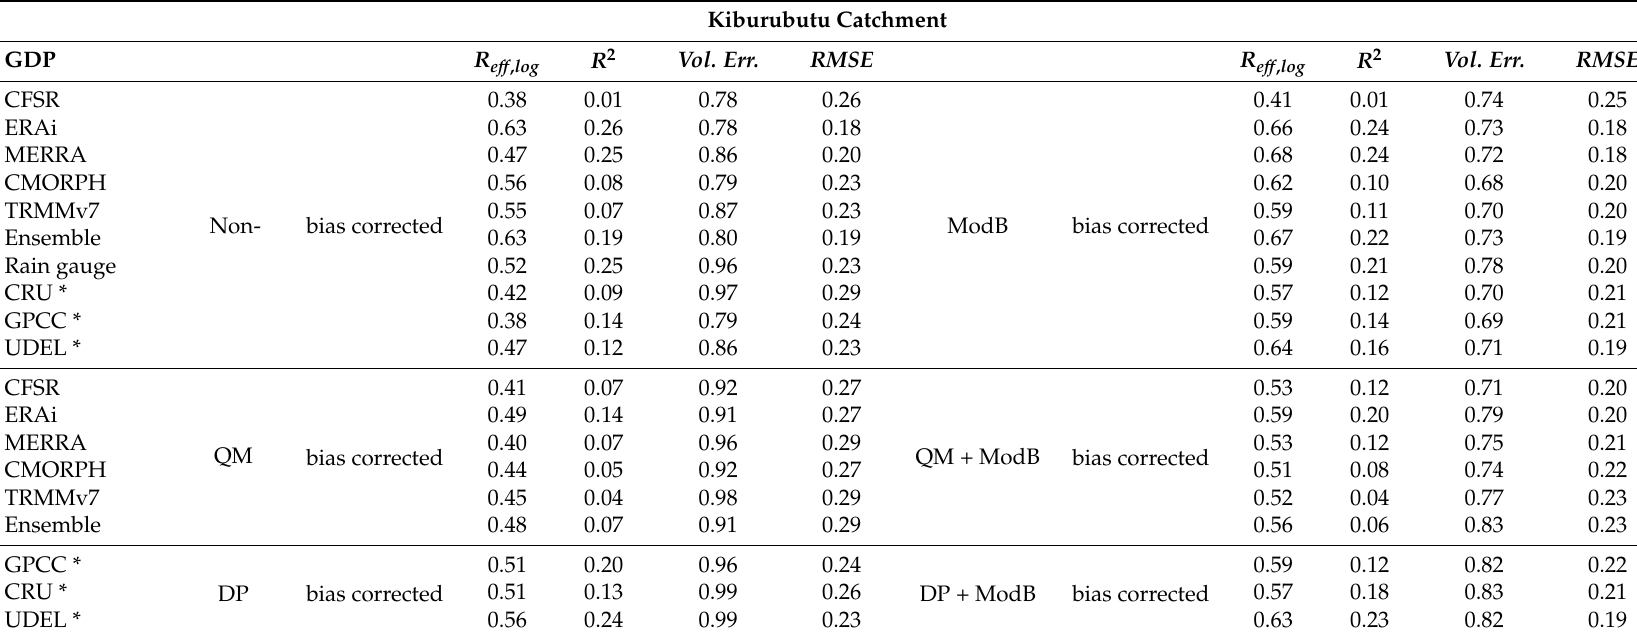
Table 5. Performance scores for KC discharge simulations. Performance is shown as R eff , log , R 2 , Volume Error ( Vol. Err. ), and RMSE values for each bias correction technique